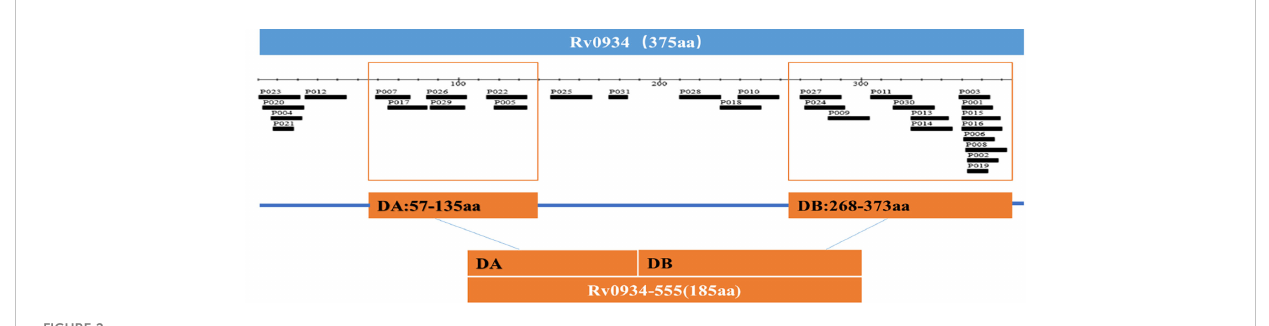
FIGURE 2 T-Cell epitope-rich domains distributed in Rv0934 . The scale unit is amino acid